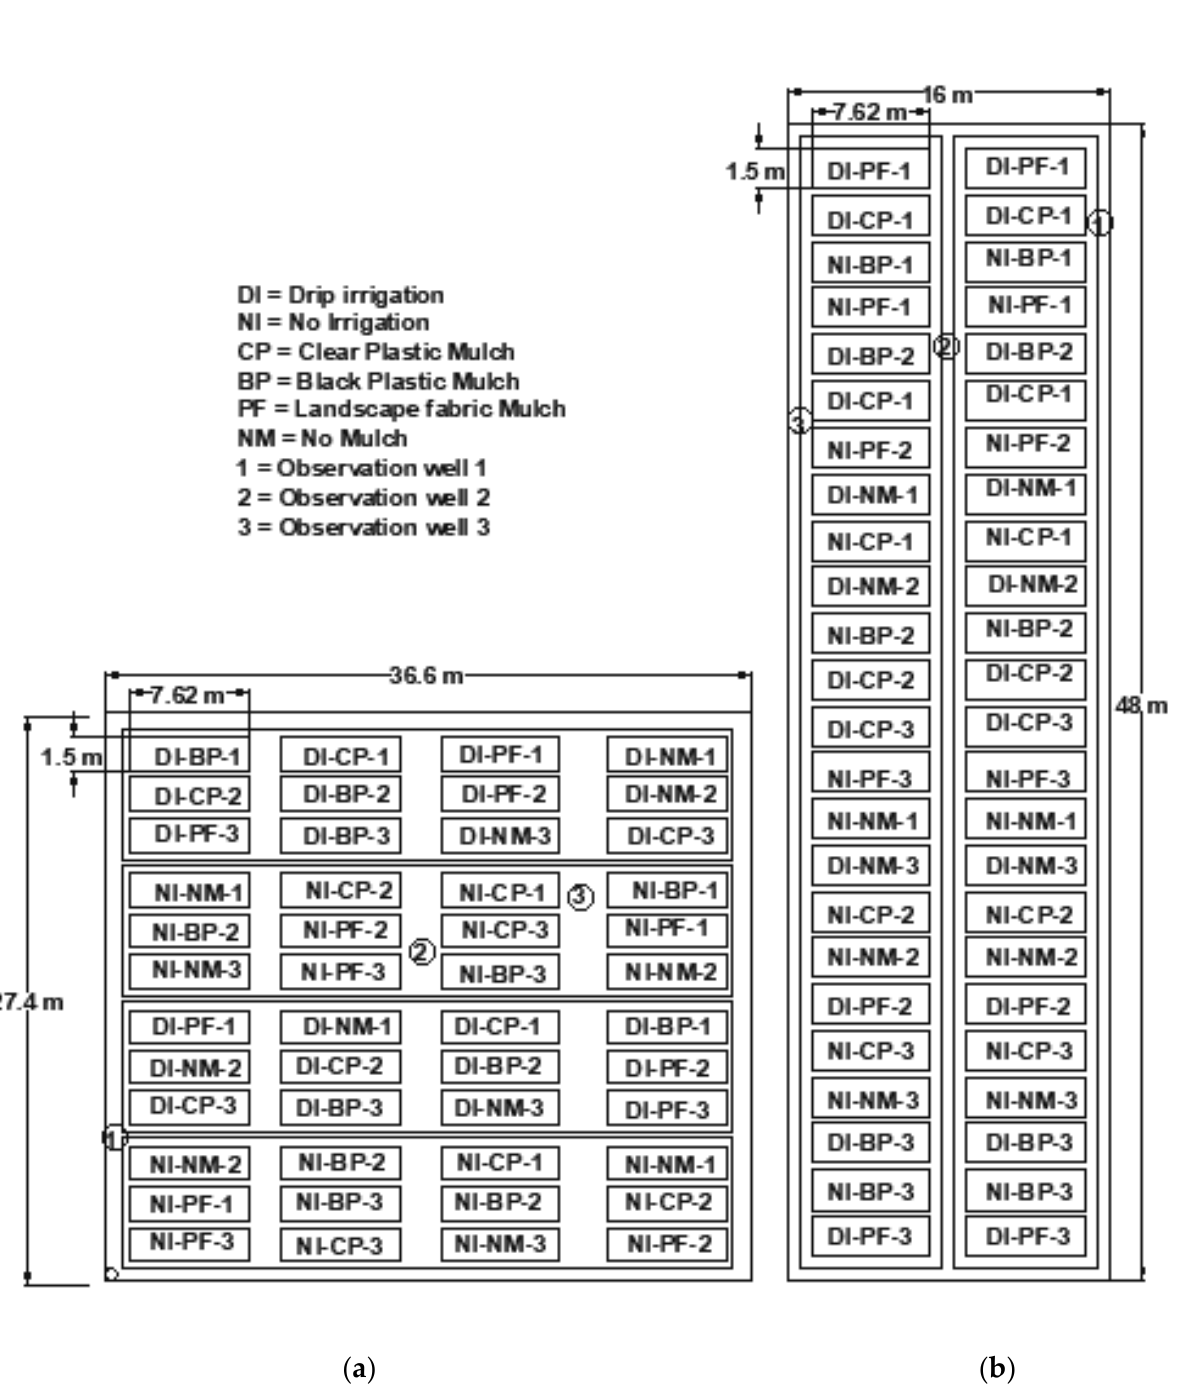
Figure 1. Randomized field layout in ( a ) 2019 field layout and ( b ) 2020 layout.